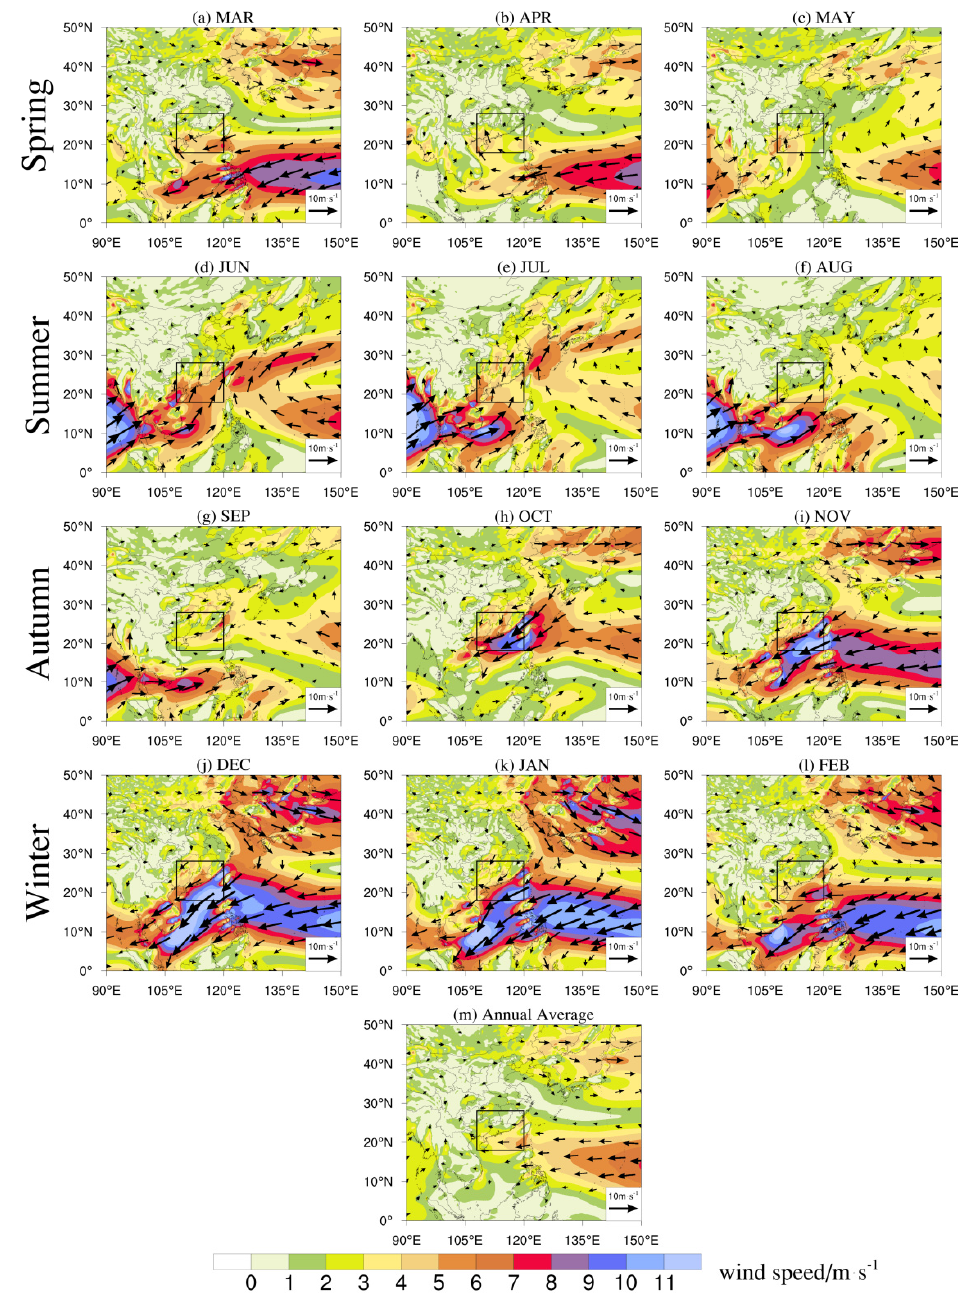
Figure 8. Distribution of 925 hPa monthly ( a – l ) and annual ( m ) average wind fields in the NSCS (region indicated in black box) and neighboring regions from 2006 to 2020.